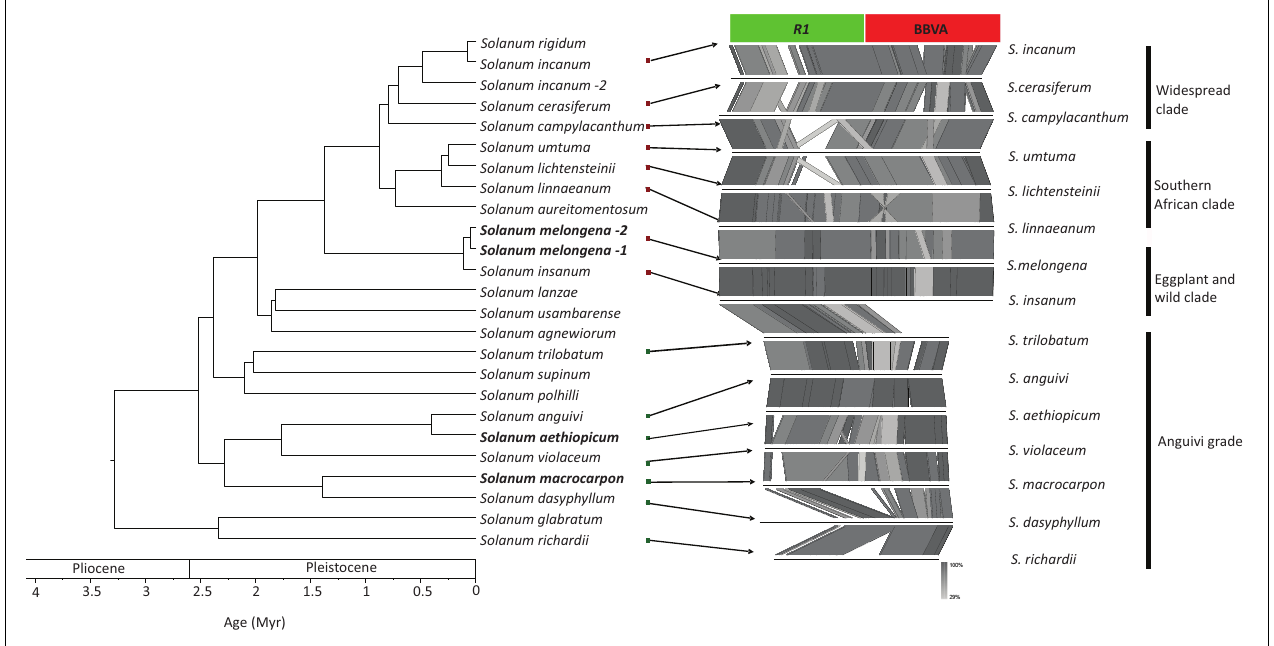
FIGURE 5 | Phylogenetic relationships of S. melongena and related Solanum species along with syntenic relationships of the left border of the V R1 locus. Left part of the figure reproduced from Aubriot et al.,